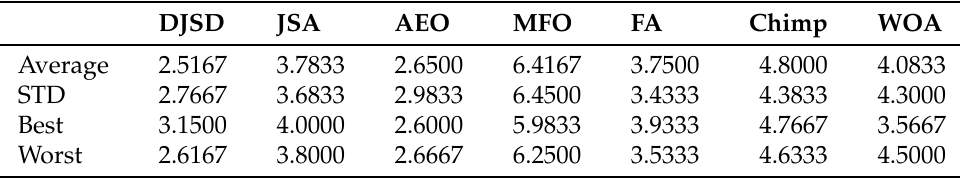
Table 7. Friedman